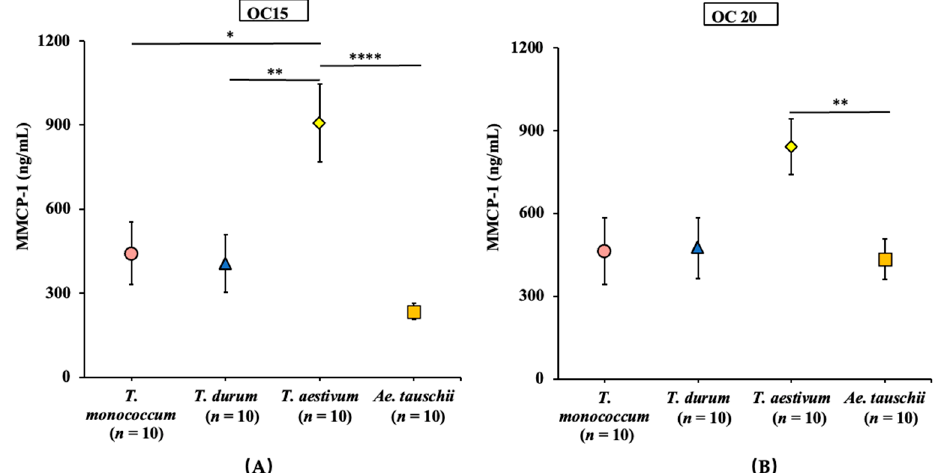
Figure 12. Comparative map of the mucosal mast cell response (MMCR) elicitation potential of SSPEs from diploid, tetraploid, and hexaploid wheats. ( A ) Average MMCP-1 blood level after 15 mg oral SSPE allergen challenge dose (OC15). ( B ) Average MMCP-1 blood level after a 20 mg oral allergen challenge dose (OC20). * p < 0.05, ** p < 0.01, **** p < 0.001, one-way ANOVA and Tukey’s